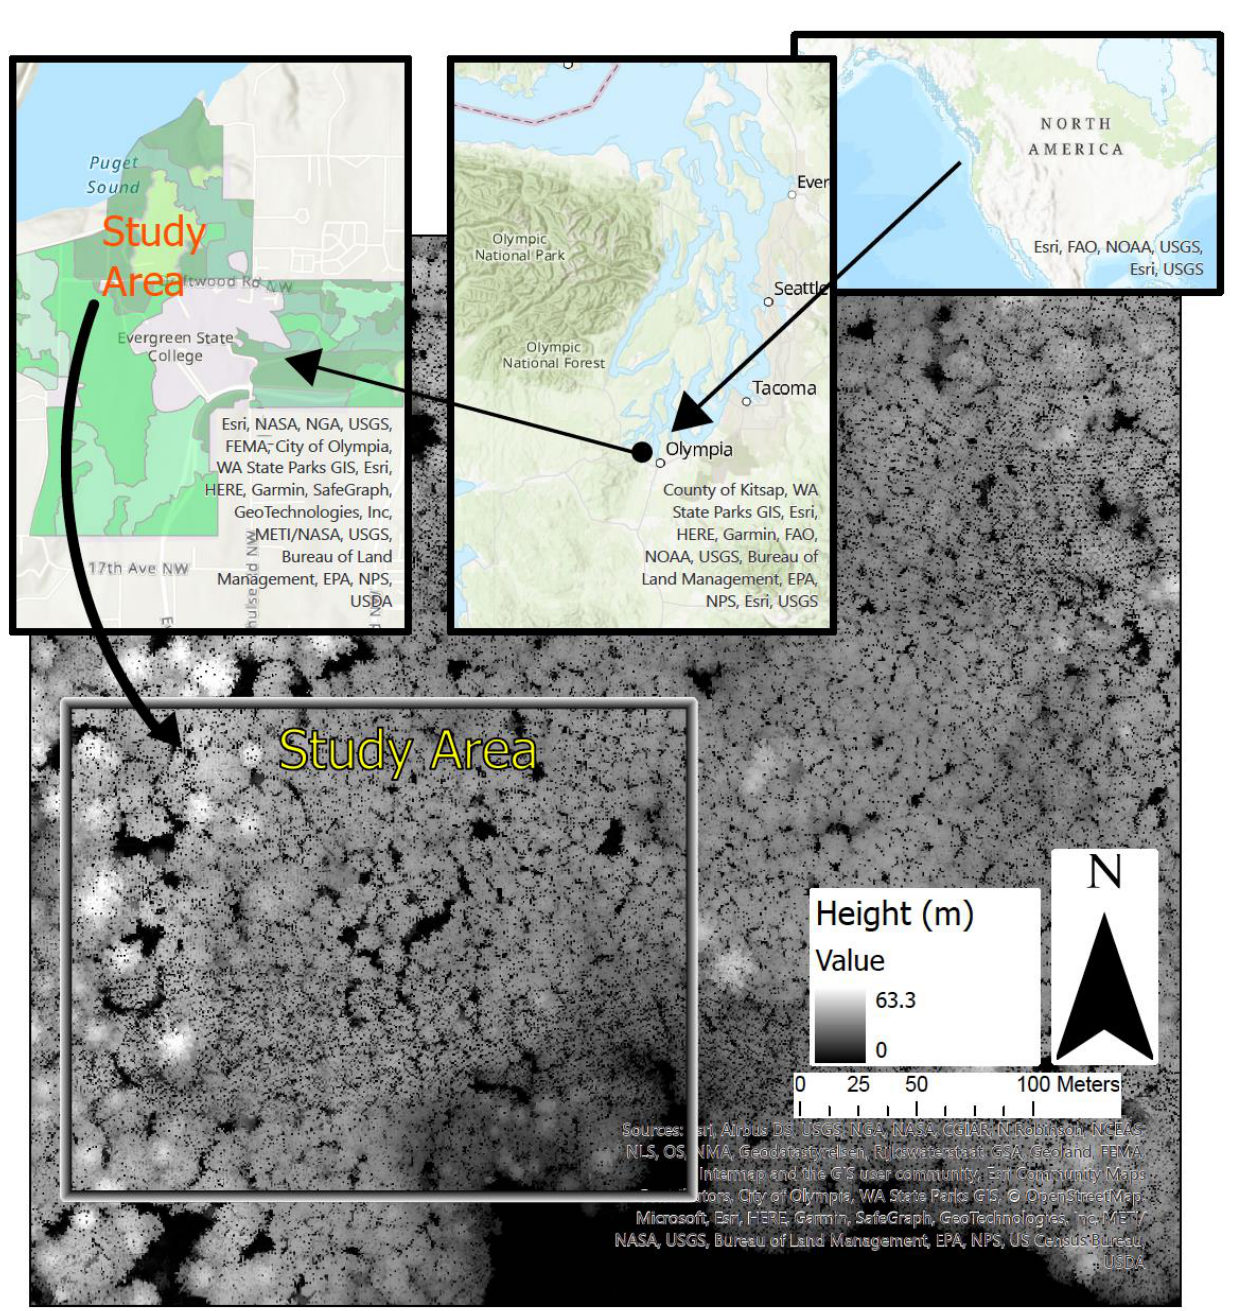
Figure 1. Study site used in the current study. Insets represent (right to left) broad geographic location, location relative to the Puget Sound (Washington state), and specific study location inside the Evergreen State College Forest Reserve. The main image represents the LiDAR-derived tree height (2017). White values represent maximum tree height (~63 m), and black represents ground. Trees used in the study ranged from 22–30 m tall within the study area. Table 1. Tree characteristics of the species used in this study.